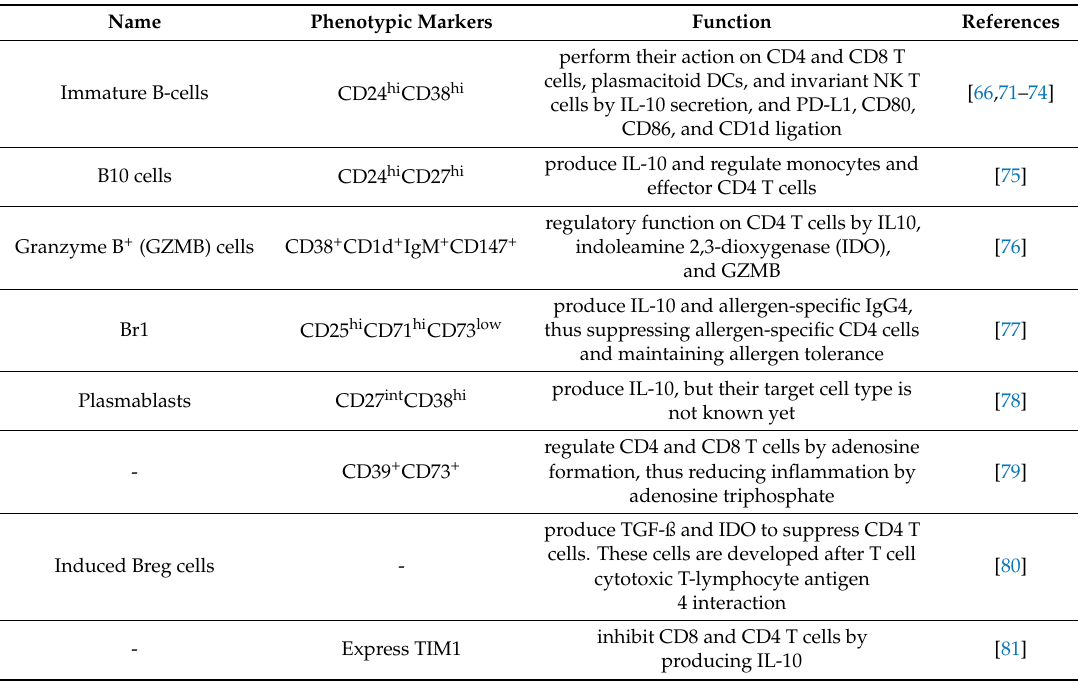
Table 1. Described B regulatory (Breg) cell subsets. DC = dendritic cells; NK = natural killer; IL = interleukin; PD-L = program death-ligand; Ig = immunoglobulin; TIM1 = T cell immunoglobulin and mucin domain; TGF = transforming growth